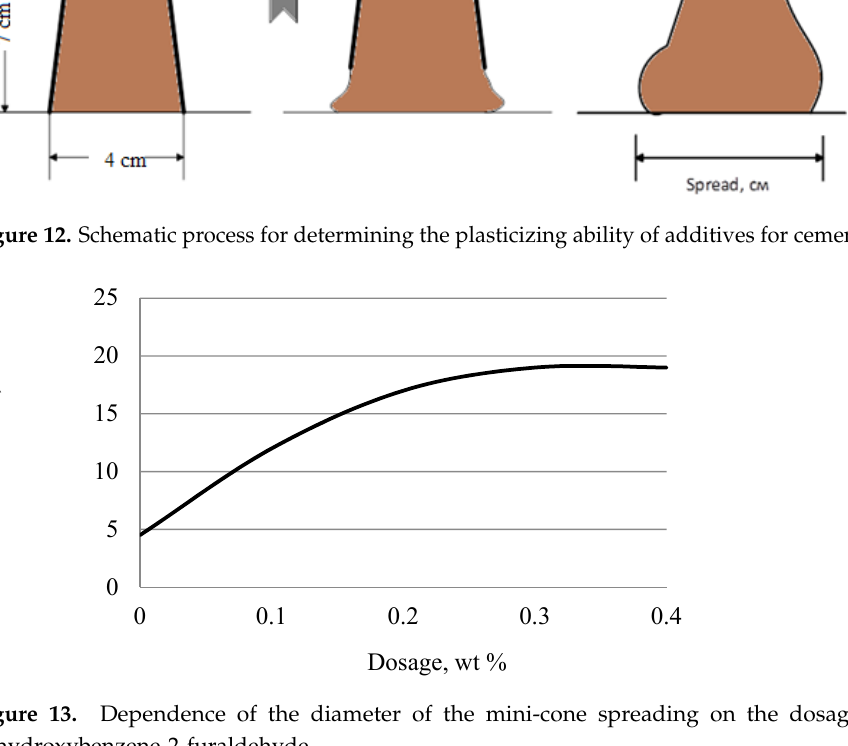
Figure 12. Schematic process for determining the plasticizing ability of additives for cement sys- tems.